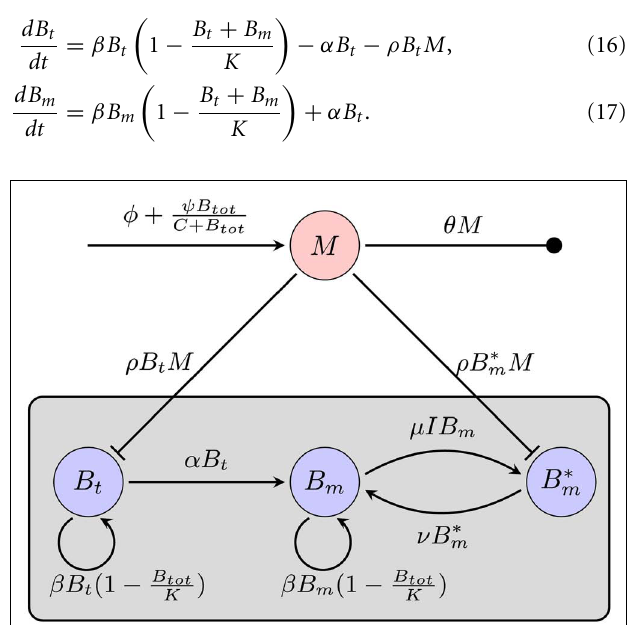
FIGURE 5 | Model of the bacterial dynamics at the infection site with molecular adaptations of the pathogen and a simple representation of the adaptive immunity. Vulnerable BB B t enter the infection site and adapt at a rate α to a state where they are not recognized by phagocytes anymore.These adapted bacteria ( B m ) can be bound by antibody I (not shown), making them susceptible again. B t : phagocytosis-susceptible bacteria, B m : adapted bacteria, B ∗ : antibody-bound bacteria, beta : bacterial m replication rate, K : carrying capacity, ρ : phagocytosis rate, φ : physiological phagocyte migration into infection site, ψ : phagocyte recruitment as infection response, C : bacterial concentration yielding half-maximal FIGURE 6 | Experimentally measured IgM titers (Barthold et al., 1991), recruitment of phagocytes, θ : phagocyte death rate, α : bacterial adaptation normalized to 1, and the corresponding function given by equation 18 rate (transition to resistant state), μ : antibody binding rate, ν antibody with I max = 1, (cid:2) t ig = 72, t 1/2 = 100 and n = dissociation rate, I antibody concentration.